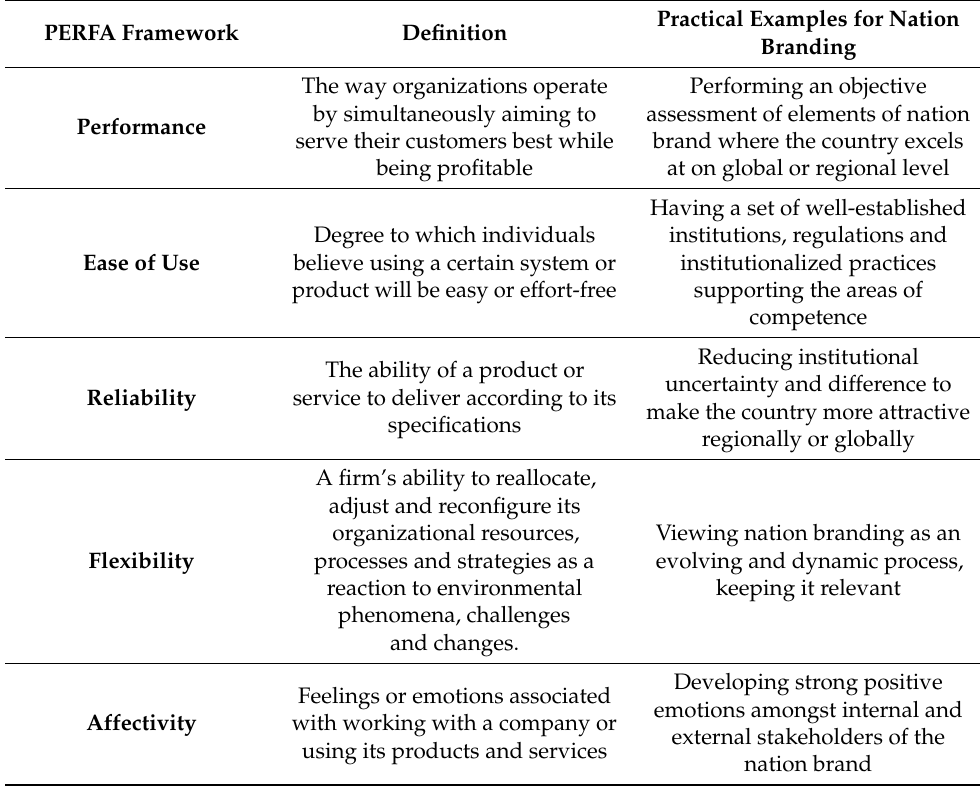
Table 2. The PERFA Framework. Source: developed by authors